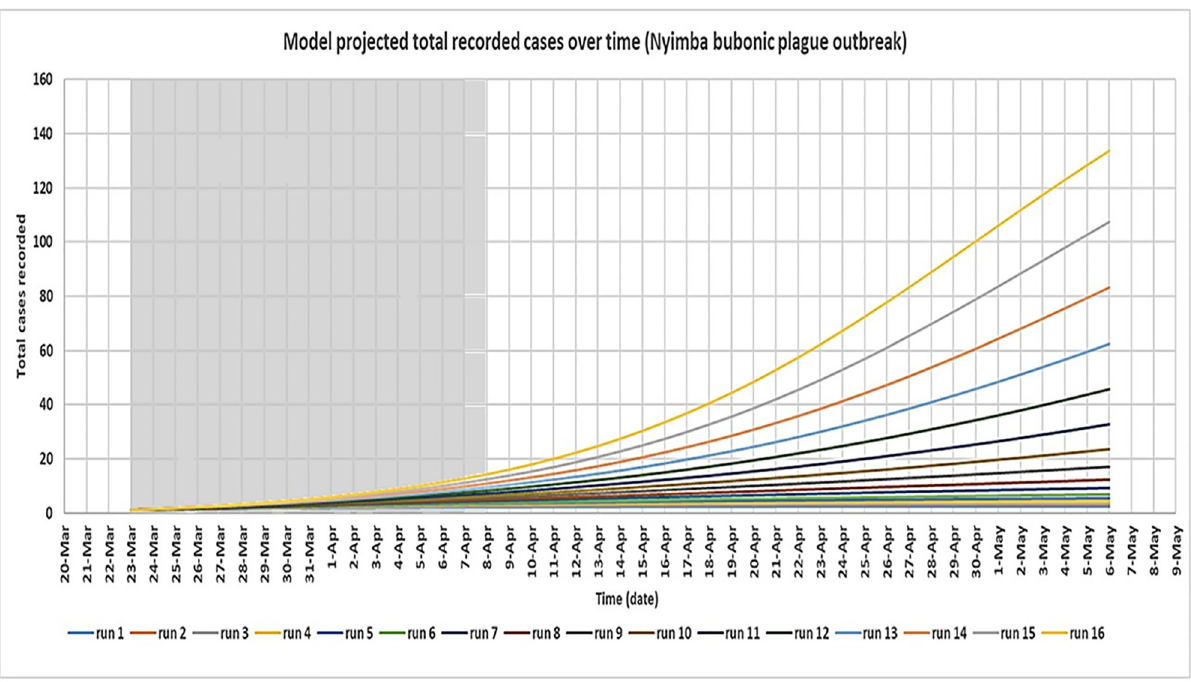
Fig 5. Derived SIR model simulations showing the model predicted total (cumulative) cases recorded over time for the Nyimba bubonic plague outbreak assuming no intervention was provided (model simulation over a 45-day period.